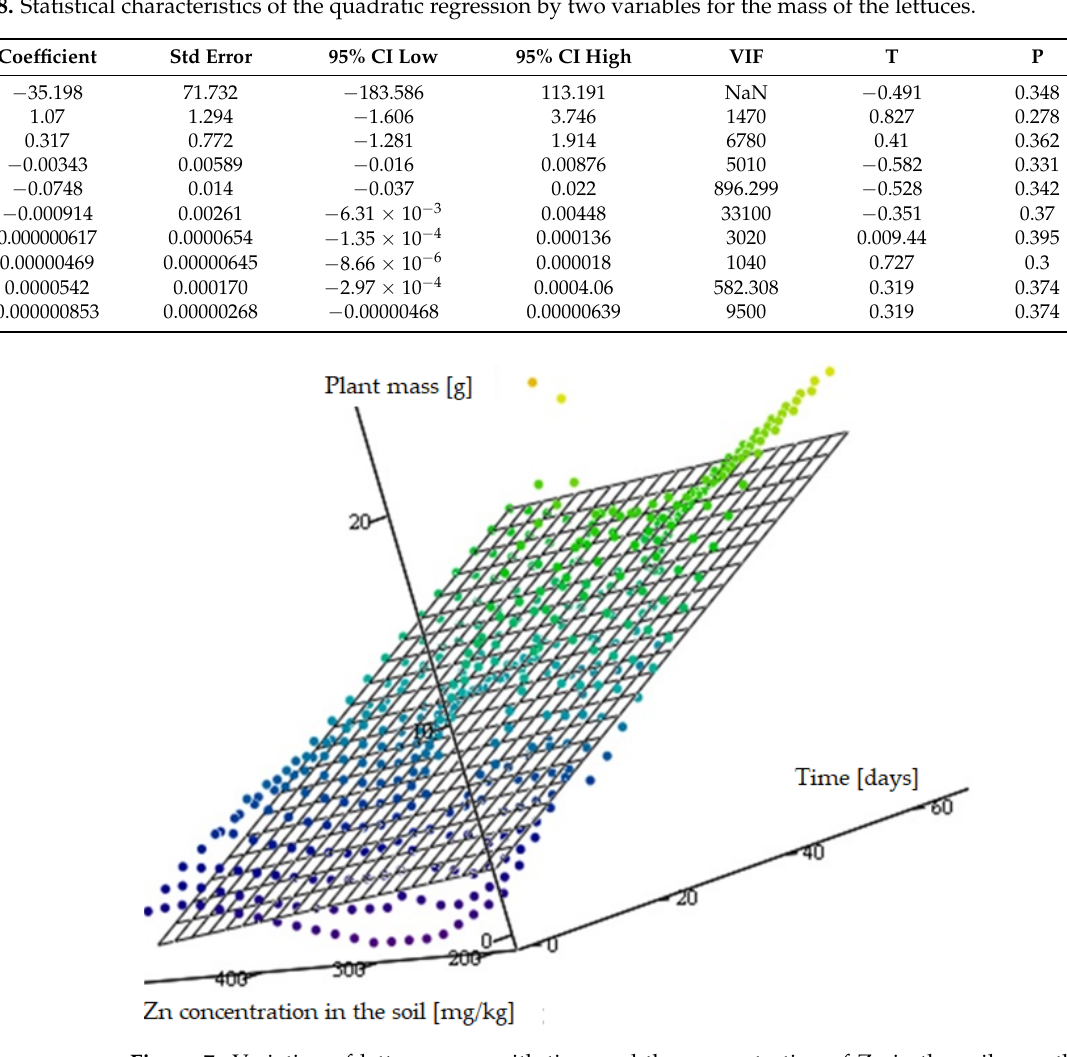
Figure 8. Variation of lettuce mass with time and the concentration of Zn in the soil, as a three- dimensional surface, corresponding to a second-degree polynomial interpolation.